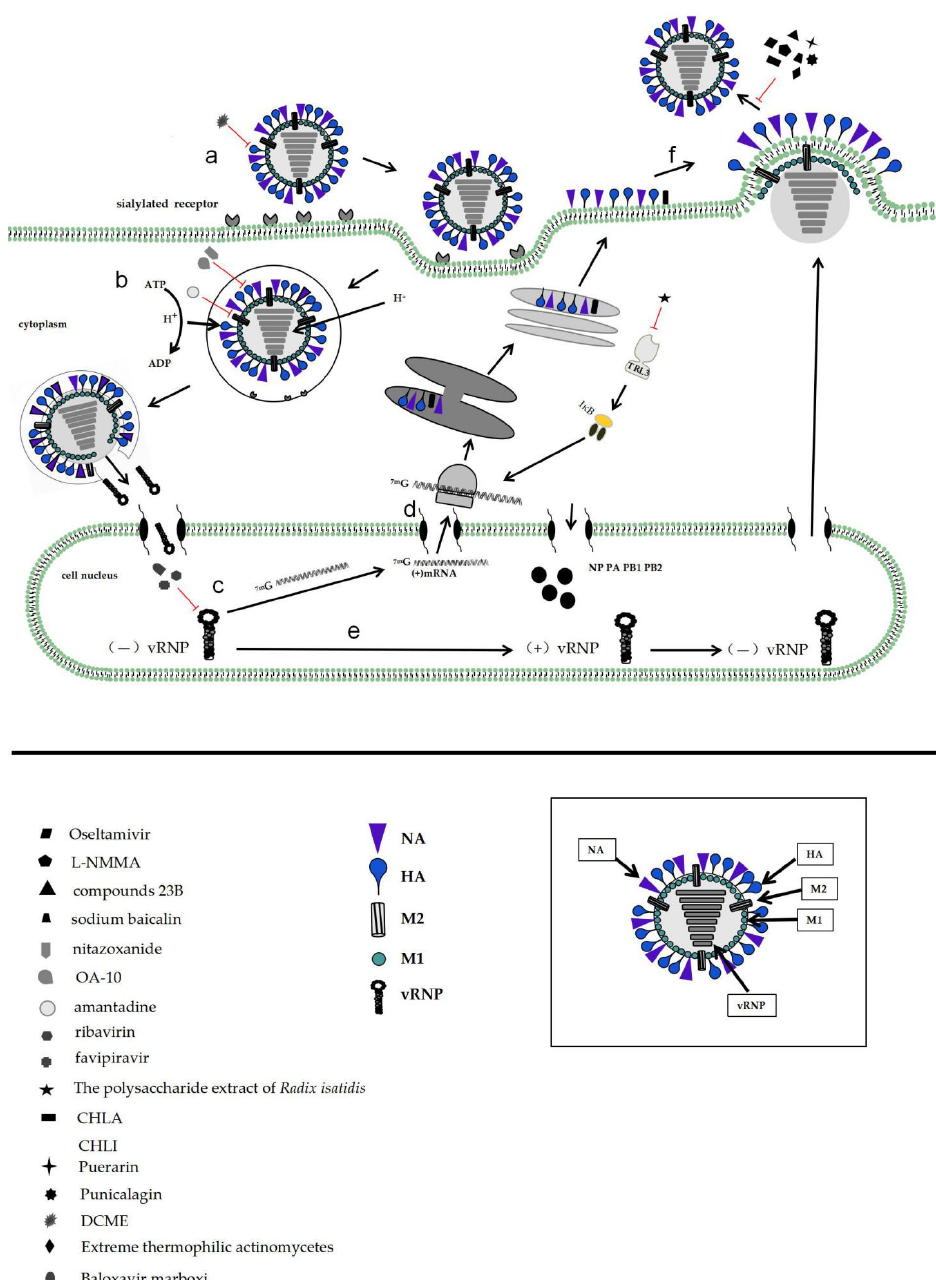
Figure 1. Replication cycle of influenza virus and targets of anti-influenza drugs. (a) Influenza virus hemagglutinin (HA) binds to sialylated host cell receptors, and then is internalised into endosomes through multiple endocytosis pathways. (b) Acidification of the endosome leads to activation of the M2 proton channel and virion acidification, resulting in virus uncoating and the release of viral genome into the cytoplasm, where it is further transported to the nucleus to begin genome replication. (c) In the nucleus, influenza virus begins to synthesize viral mRNAs. (d) HA, neuraminidase (NA) and M2 are processed in the Golgi body and the endoplasmic reticulum, and then transported to the cell surface. (e) Influenza virus polymerase can synthesize both viral mRNAs and vRNAs. vRNAs are first converted into positive-stranded cRNAs, and then new vRNAs can be synthesized using cRNAs as templates. (f) Viral proteins and genomic RNA are transported to the cell surface to assemble progeny viruses. Then, influenza virus neuraminidase (NA) cuts off the HA-receptor bond to allow progeny viruses to be released from the surface of the infected cell and proceed to infect new cells. The sites of action of antiviral drugs are shown in red.